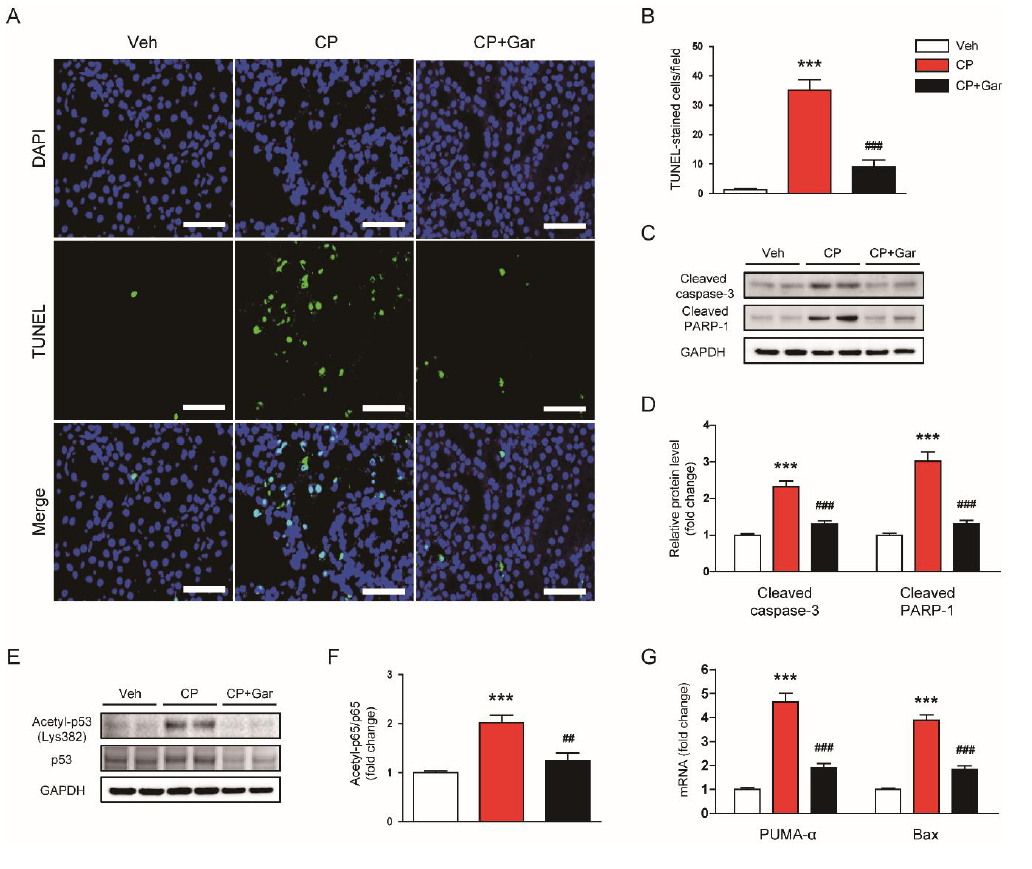
Figure 5. Effect of garcinol on apoptotic cell death in cisplatin-injected mice. ( A ) Terminal deoxynucleotidyl transferase-mediated deoxyuridine triphosphate nick end labeling (TUNEL) staining of kidney tissues. Scale bar = 50 μm. ( B ) Number of cells stained with TUNEL. ( C ) Immunoblottings of cleaved caspase-3 and cleaved poly(ADP-ribose) polymerase-1 (PARP-1). ( D ) Quantification of immunoblots for cleaved caspase-3 and cleaved PARP-1. ( E ) Immunoblottings of acetyla-p53 (Lys382) and p53. ( F ) Quantification of immunoblot for acetyla-p53. ( G ) The mRNA expression of p53-upregulated modulator of apoptosis (PUMA) and Bax. n = 8 per group. *** p < 0.001 vs. Veh. ## p < 0.01 and ### p < 0.001 vs. CP.